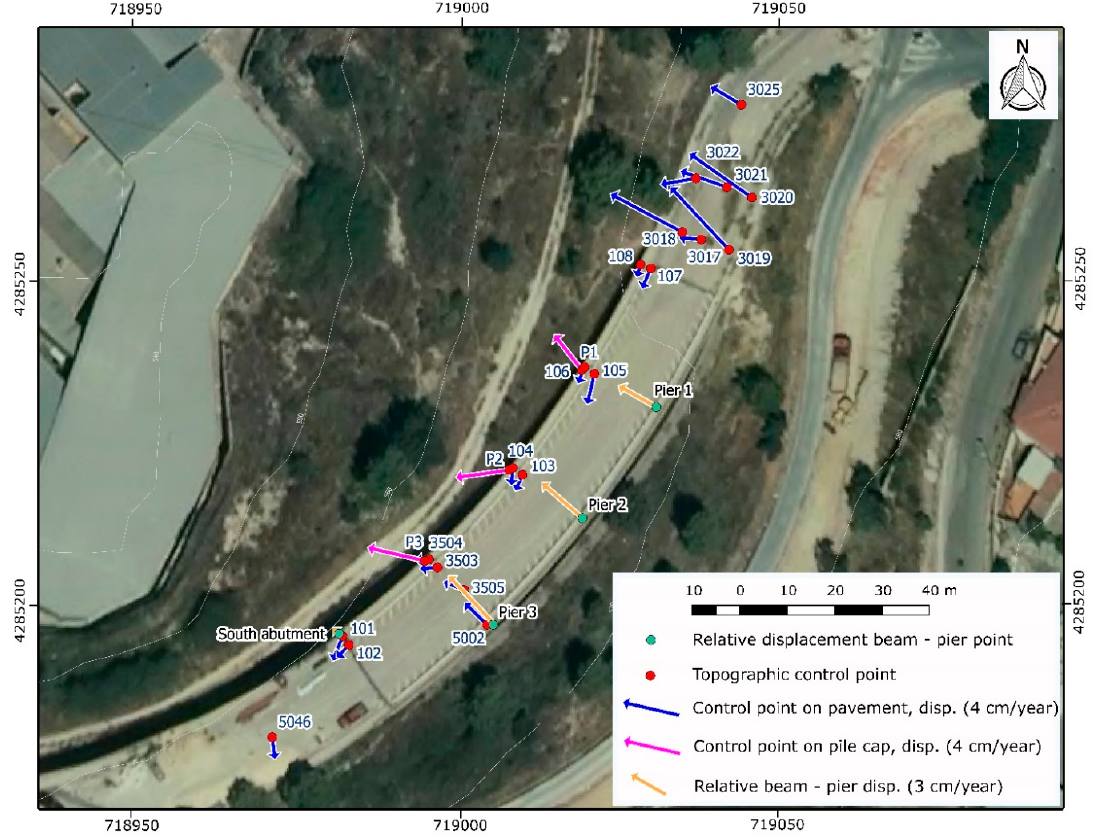
Figure 11. Horizontal displacements of the control points measured by topographic surveys and relative displacements between the precast concrete beams and the supporting piers. All the topographic control points are located on the road pavement, except for P1, P2 and P3 which are on the pile cap surface below the bridge.